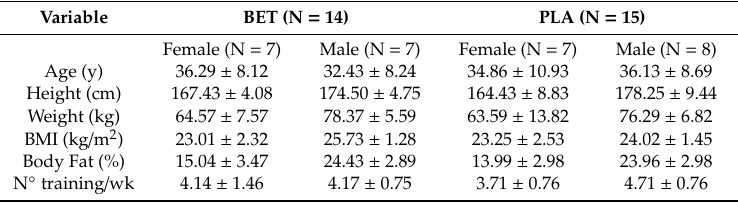
Table 1. Baseline characteristics of Betaine (BET) and placebo (PLA)